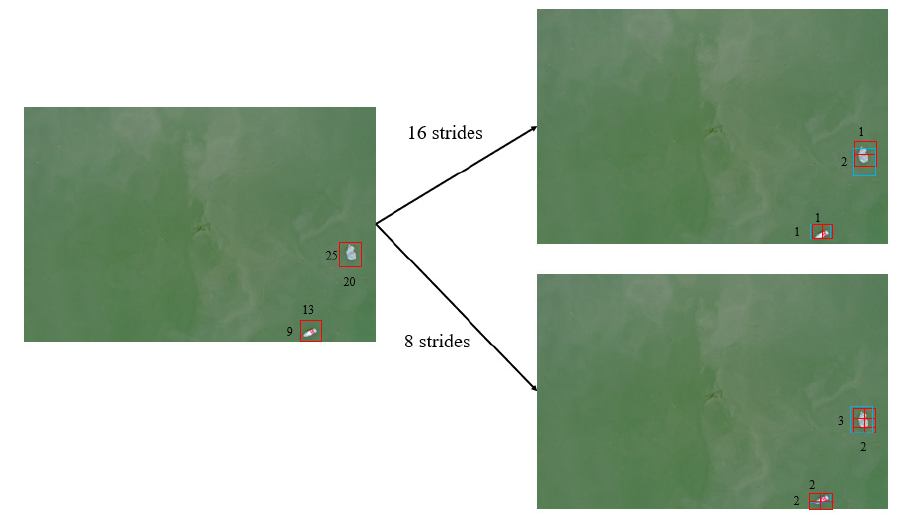
Figure 7. Step comparison chart.